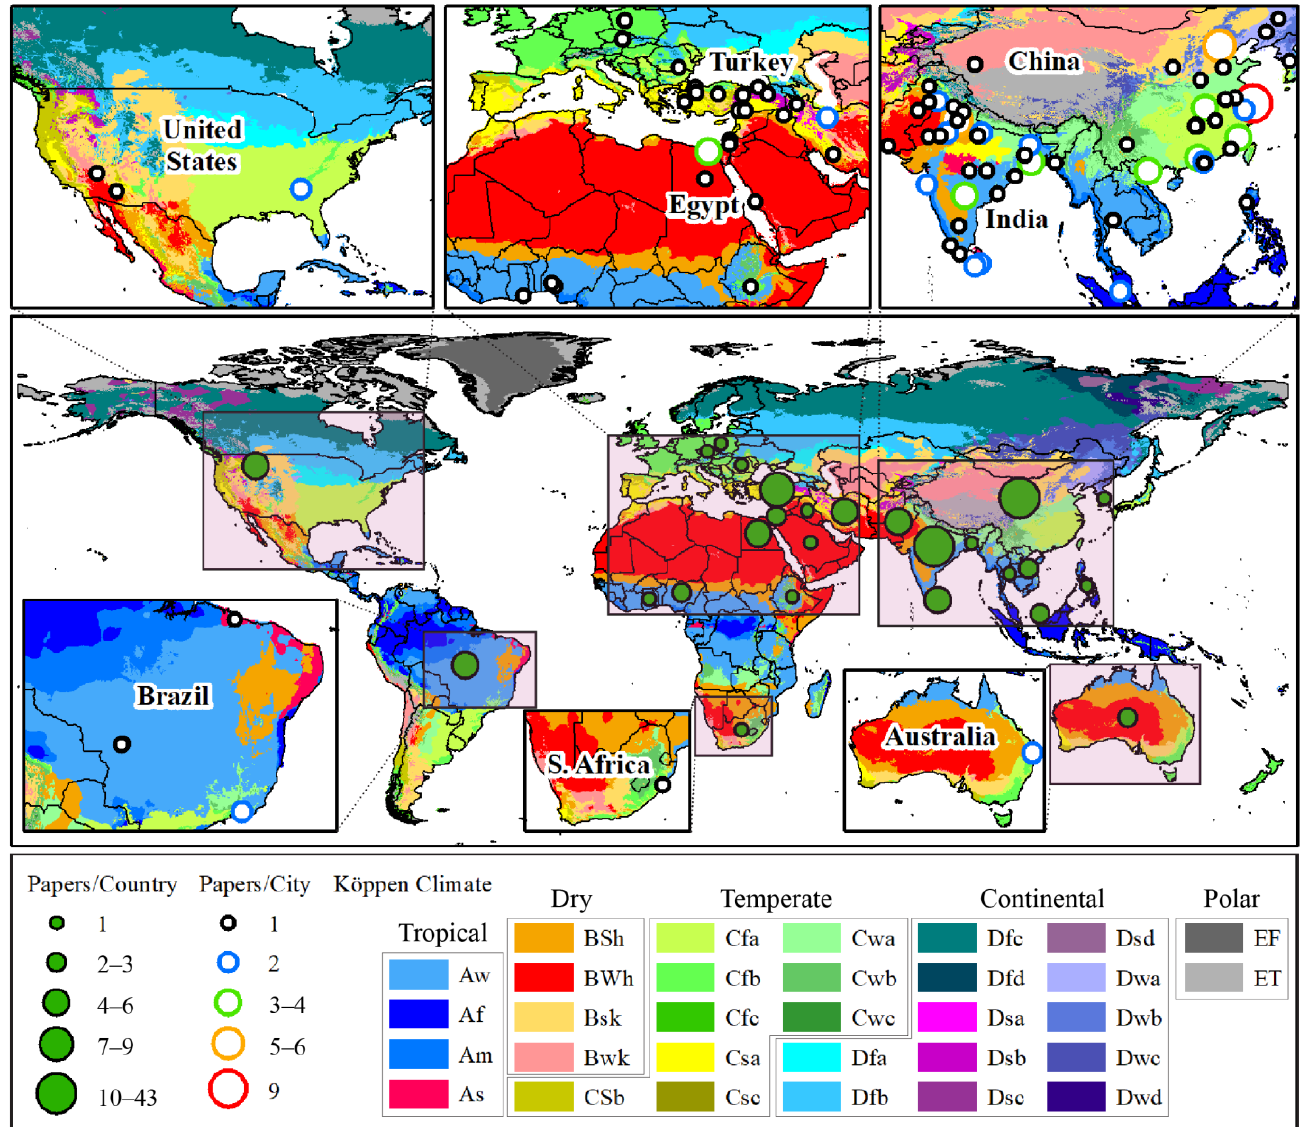
Figure 3. Spatial distribution of case studies aggregated based on countries where cities are located with regard to the world’s Köppen climate classification according to [42] (licensed under CC BY 4.0). The circle size on the left indicates the range of papers count per country.